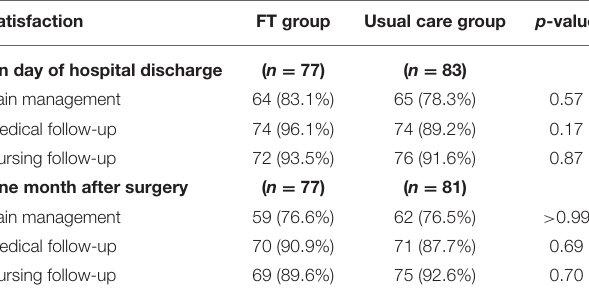
TABLE 3 | Patient satisfaction on day of hospital discharge and at 1-month post-operative follow-up